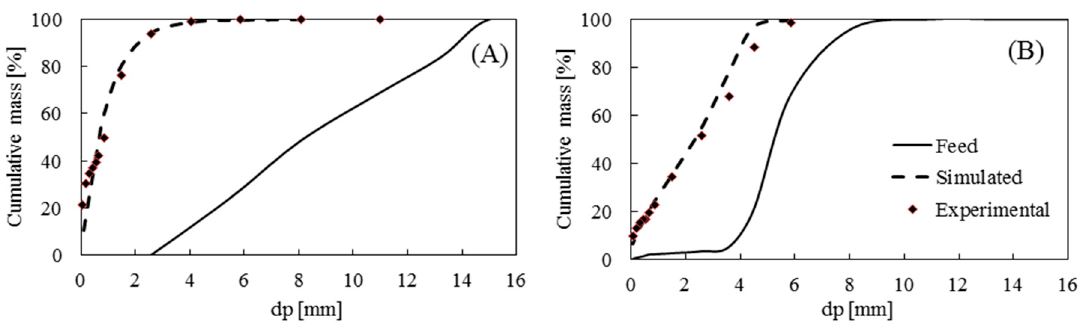
Figure 19. Feed, experimental and simulated curves using the calc-silicate material experiment with a different static gap and a heterogeneous particle size distribution ( A ) PT-1 and ( B ) MT-1.